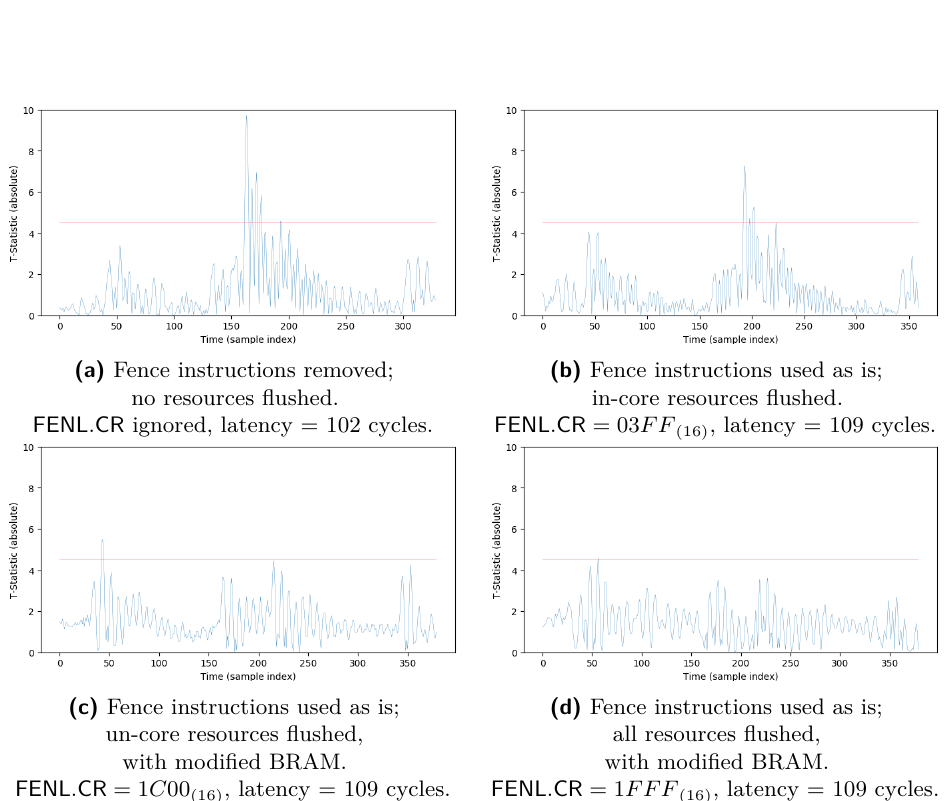
Figure 11: Results for experiment 4, relating to leakage from Figure 10 as executed on the SCARV core (randomisation-based flush semantics, bubbling variant). Note that the t-statistic is plotted in absolute form; the plots are cropped wrt. the target kernel, which has a longer latency post -insertion of fence instructions.